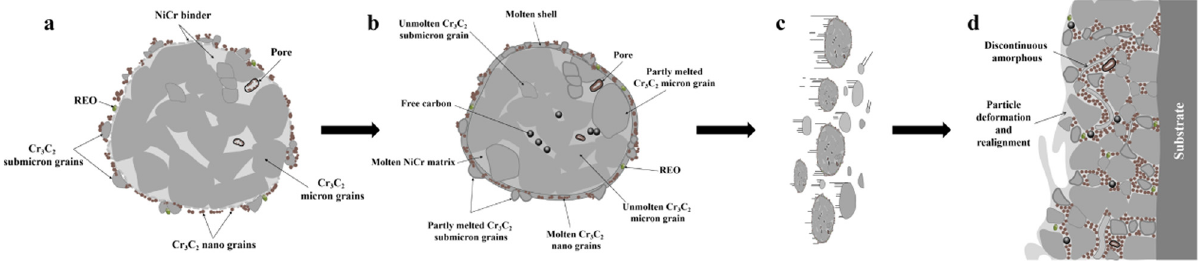
Figure 10: Schematic of the formation of the multimodal structure coatings: ( a ) original particle, ( b ) molten part of the particle, ( c ) particle deformation, and ( d ) cross section of the multimodal